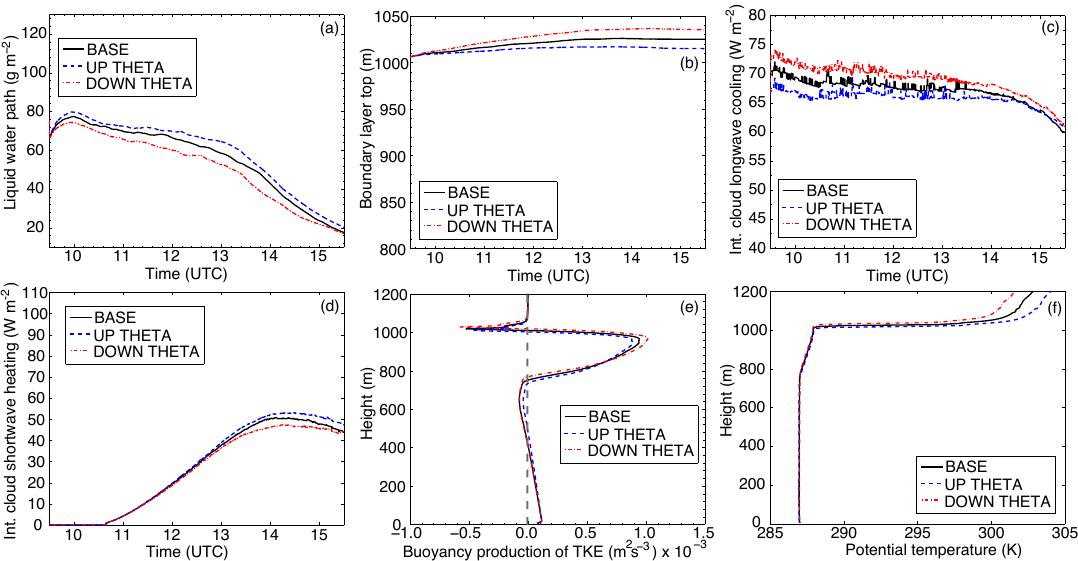
Fig. 6. LES output showing STBL response for changes in potential temperature jump across the cloud top interface. Time series of quantities, shown in (a) to (d) , are domain averaged and vertically integrated. Vertical profiles, shown in (e) and (f) , are domain averaged and temporally averaged over the hour of observation (12:30 to